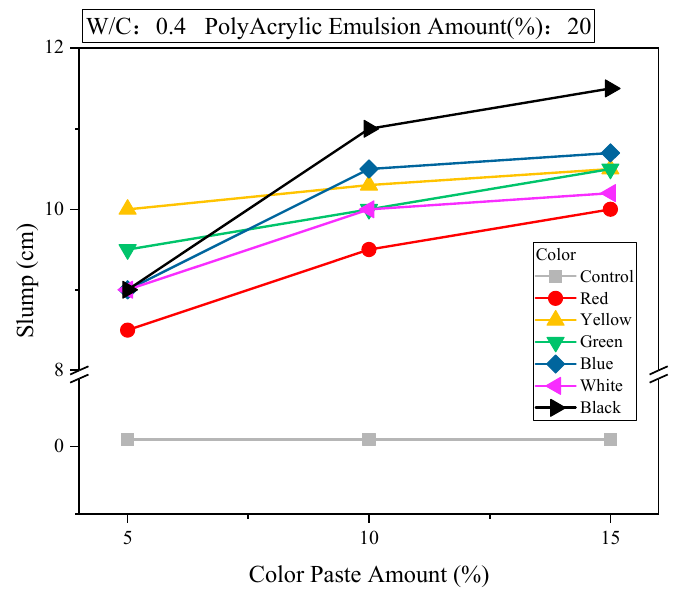
Figure 3. Slump of mortar with different proportions of inorganic color paste.